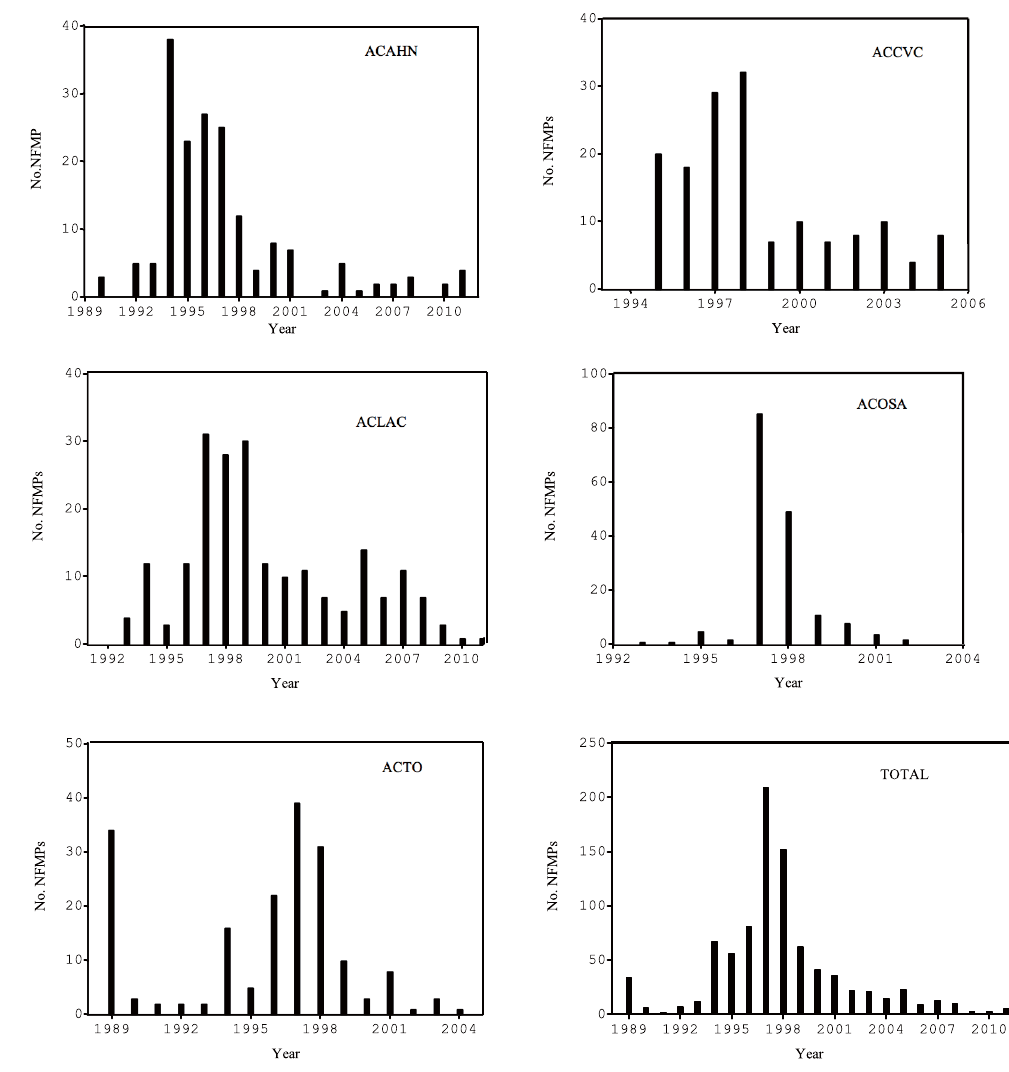
Figure 3. Historical trends of forest management plans presented to the regional offices for five Conservation Areas in Costa Rica and the total number of records across Conservation Areas; the sources for the original data are archives of the regional offices of the National System of Conservation Areas, however, data presented here was is following processed and analyzed by